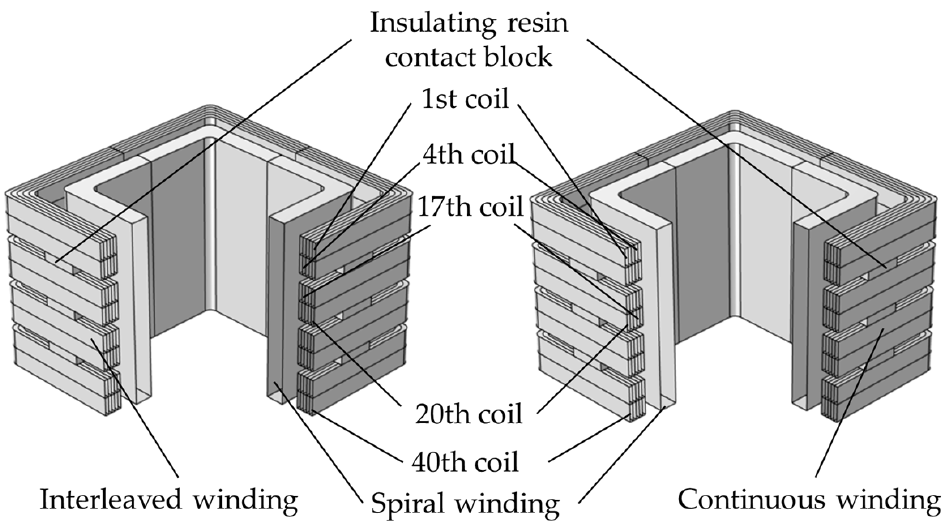
Figure 5. Schematic diagram of interleaved and continuous winding models. As shown in Figure 6, there are 40 turns in the primary winding. Each coil is